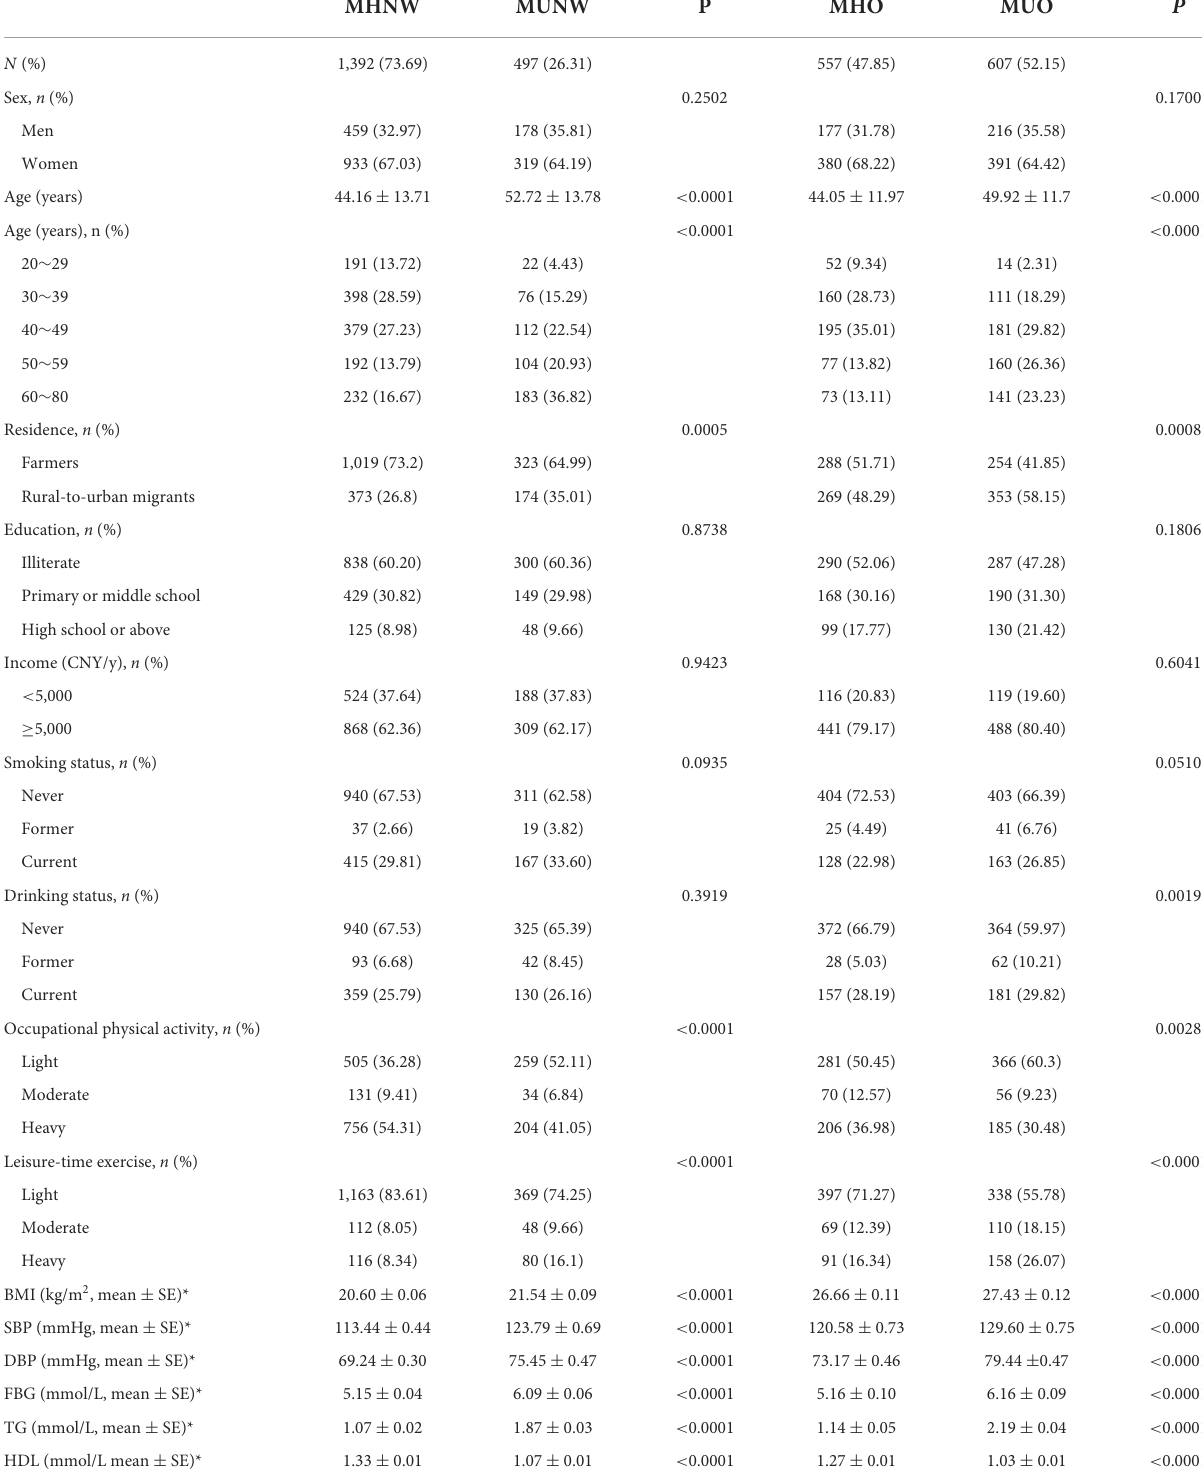
TABLE 1 Demographic and metabolic characteristics in participants from the Yi Migrant